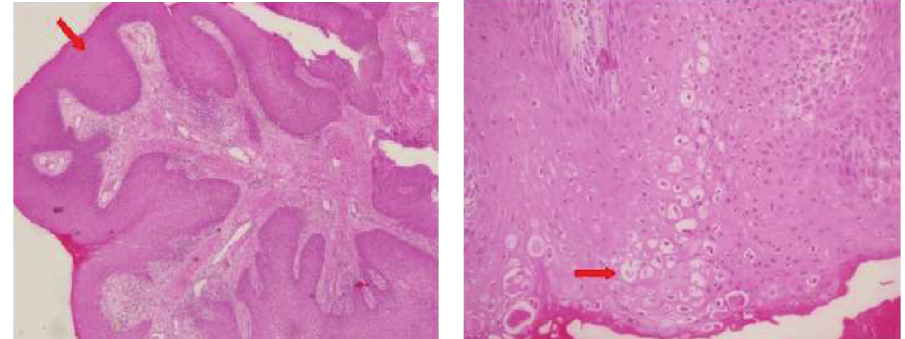
Figure 5: Papillary structures made by hyperplastic squamous epithelium are seen in fibrovascular core (H&E, × 40), and koilocytic cells with perinuclear vacuolisation are seen in hyperplastic squamous epithelium (H&E, × 200).